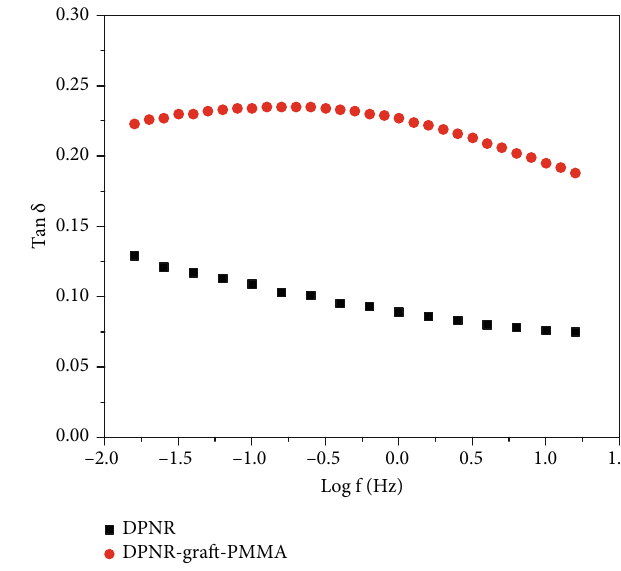
Figure 10: Loss tangent in the plateau region vs frequency at 298 K for DPNR and DPNR-graft-PMMA 15